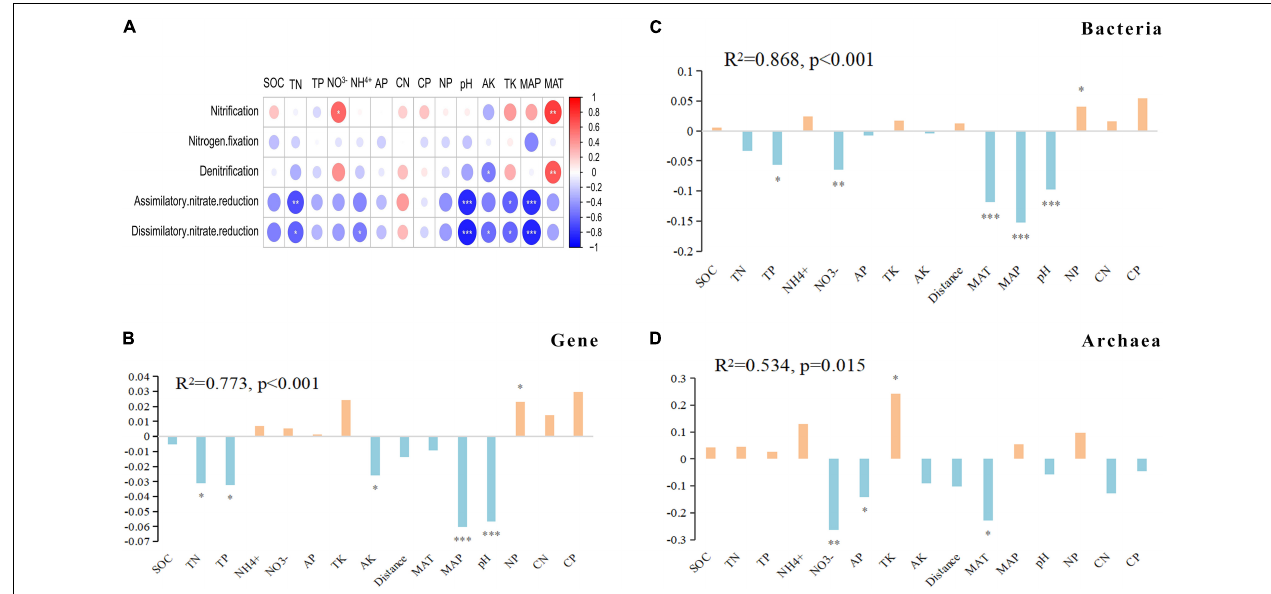
FIGURE 5 | Contributions of environmental properties to the dissimilarities of the genes and microbial communities for N-metabolism. (A) The heatmap shows correlations between environmental factors and metabolic pathways. The circle size represents the variable importance. Red and blue represent positive and negative Spearman correlations, respectively. (B–D) The bar plots show the coefficient of the multiple regression of dissimilarity matrices (MRM) between the genes and bacterial archaeal communities and environmental properties. *** p < 0.001, ** p < 0.01 and * p < 0.05.